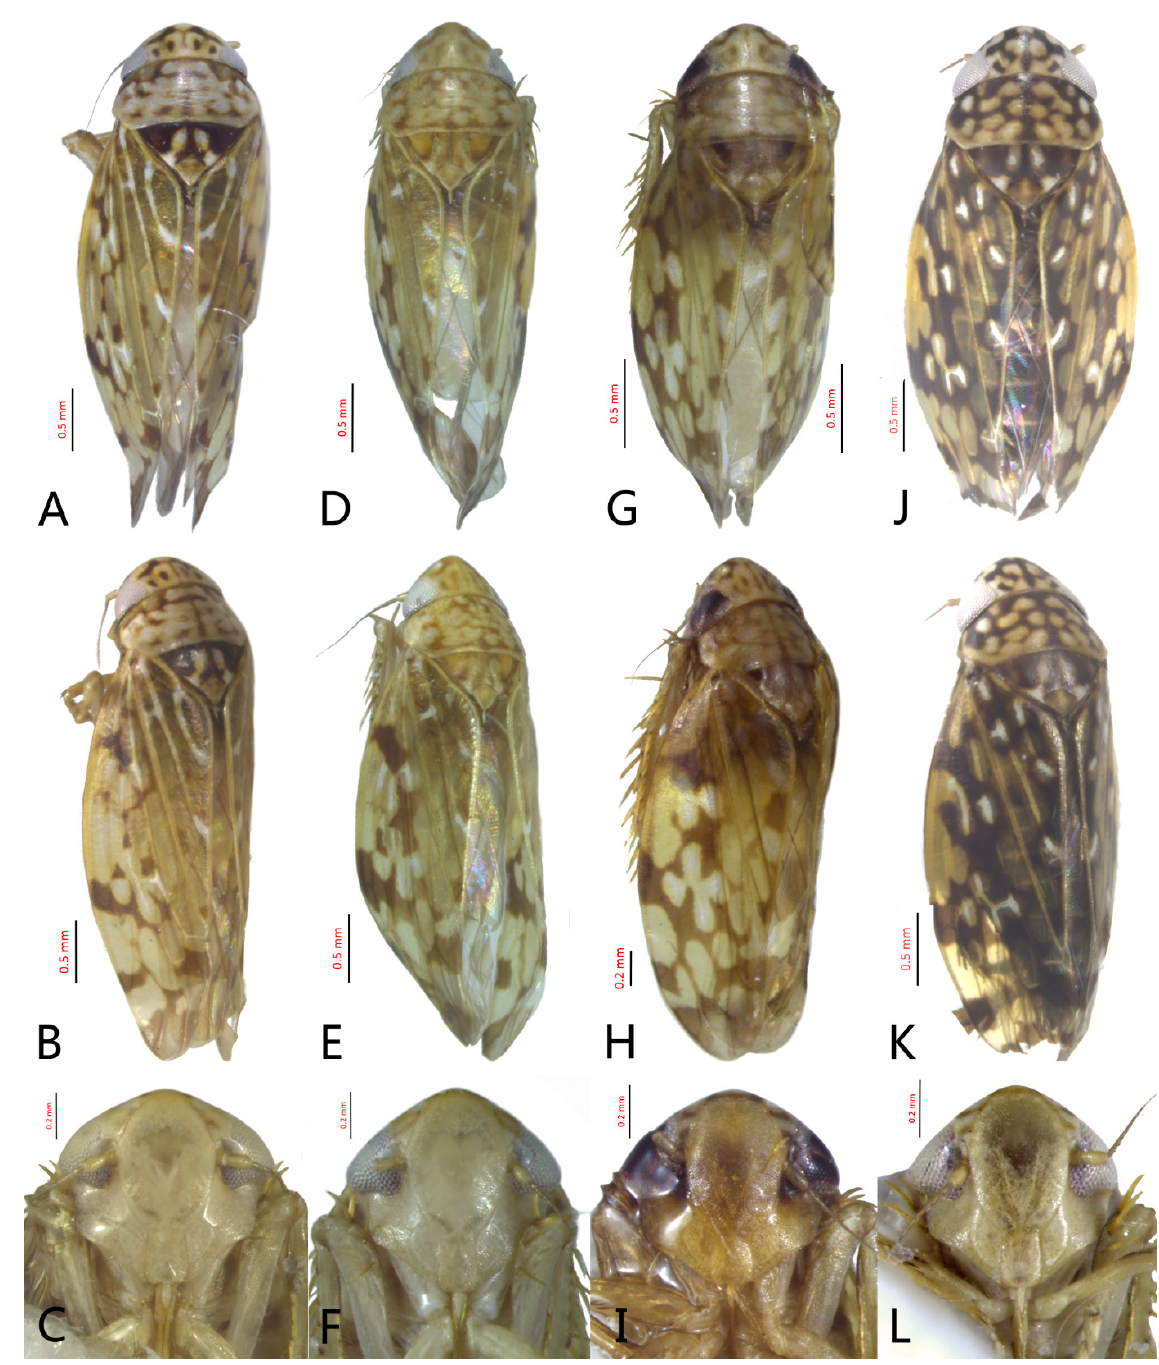
Figure 8. Male habitus of Xestocephalus . ( A – C ) X. binarius sp. nov.; ( D – F ) X. densprint sp. nov.; ( G – I ) X. toroensis ; ( J – L ) X. chrysanthemum sp. nov. ( A , D , G , J ) dorsal view; ( B , E , H , K ) laterodorsal view; ( C , F , I , L ) face.